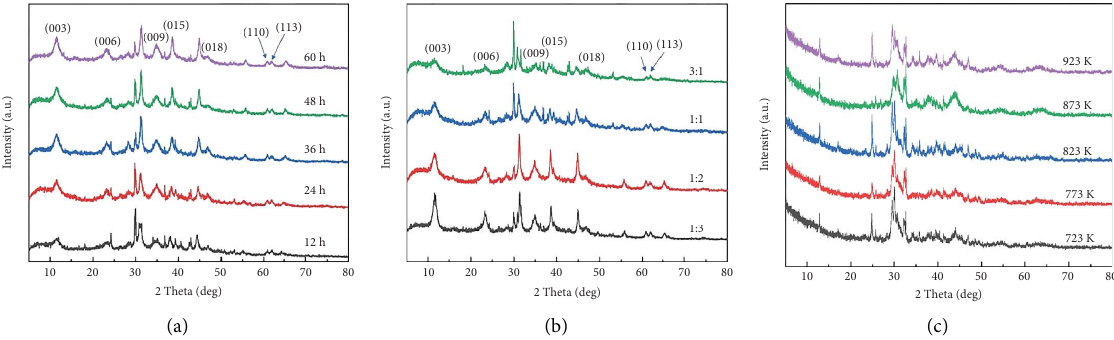
Figure 1: XRD patterns of KF/Mg-Ca-Al HTLCs MS catalysts with (a) diferent hydrothermal times, (b) Ca/Mg addition ratios, and (c) calcination temperatures (other conditions: Ca/Mg � 1:1, hydrothermal time: 24 h, and Mg-Ca-Al HTLCs calcined at